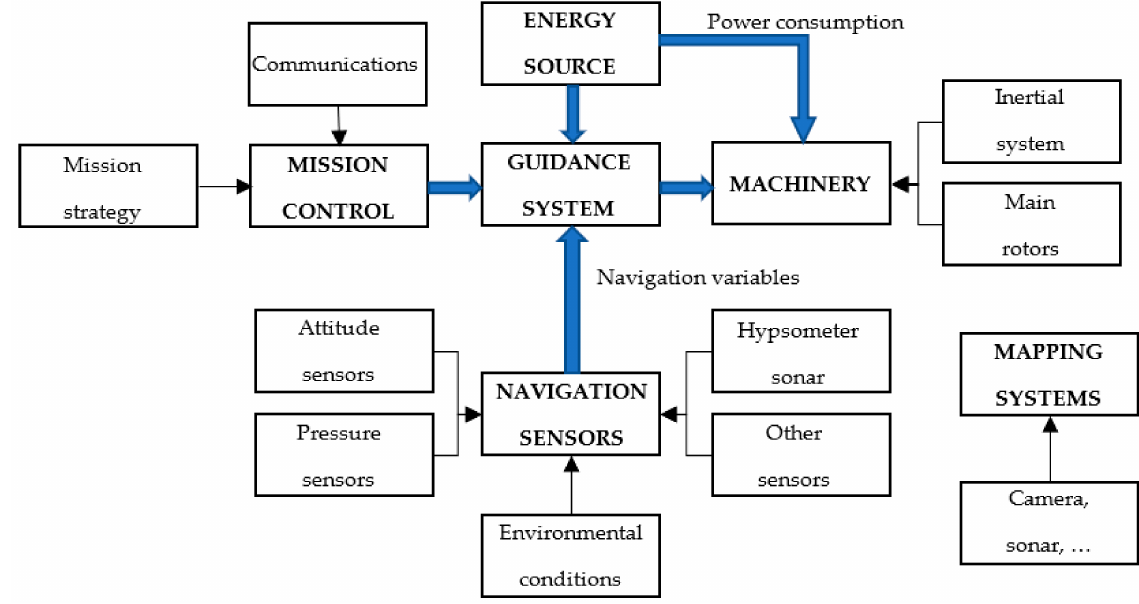
Figure 1. Scheme of an Autonomous Underwater Vehicle